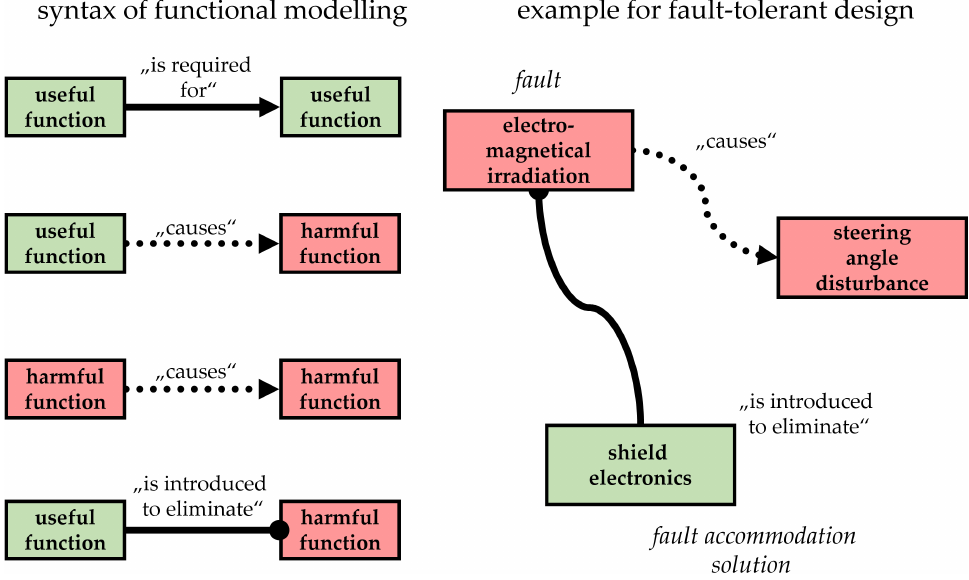
Figure 4. Accommodation of the fault “steering angle